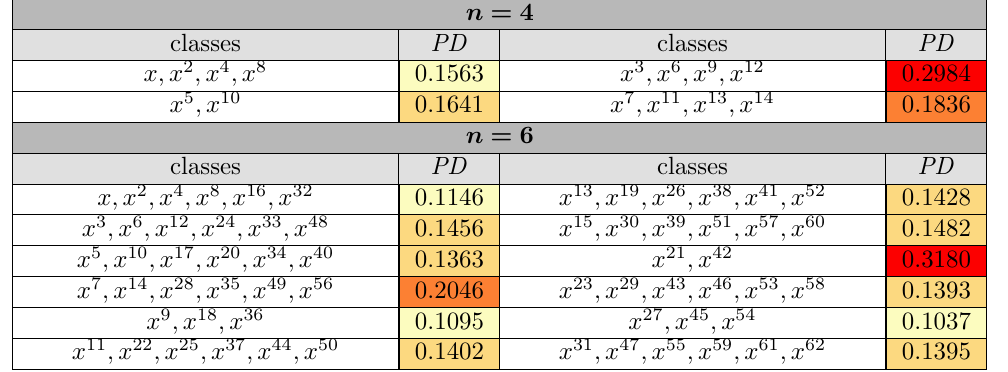
Table 1: The PD of different cyclotomic classes for n ∈ { 4 , 6 } based on irreducible polynomials x 4 + x + 1 and x 6 + x + 1. For the sake of brevity, the complete table for n = 8 is shown in Appendix